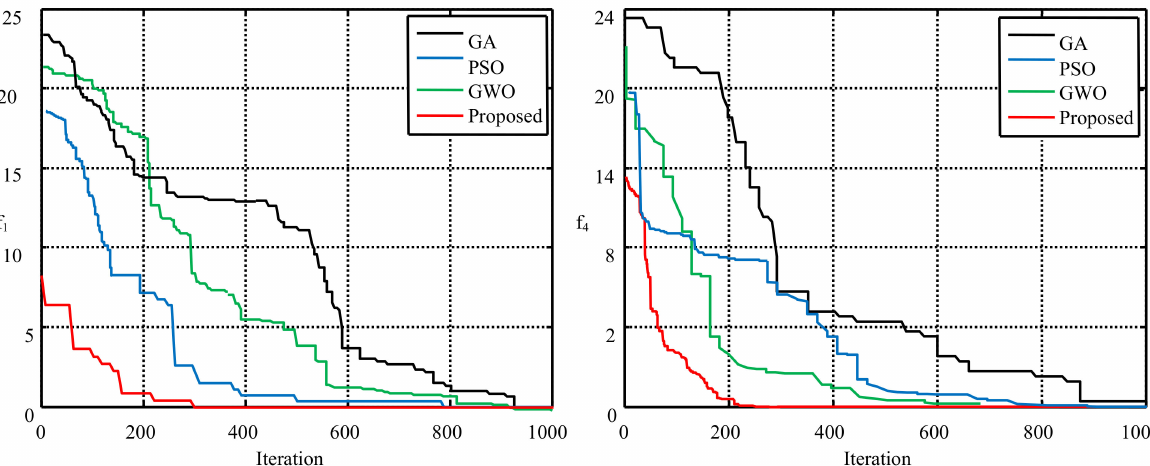
Figure 8. Evolution rate comparison for two benchmark functions, f1 and f4, versus the number of function evaluations. As can be seen in the figures, the proposed method converges faster than other methods and has found a more optimal solution. On the other hand, it is clear from Figure 8 that the proposed method has less standard deviation and is more robust in solving the problem. The solutions proximity shows their high performance and the used model has low standard